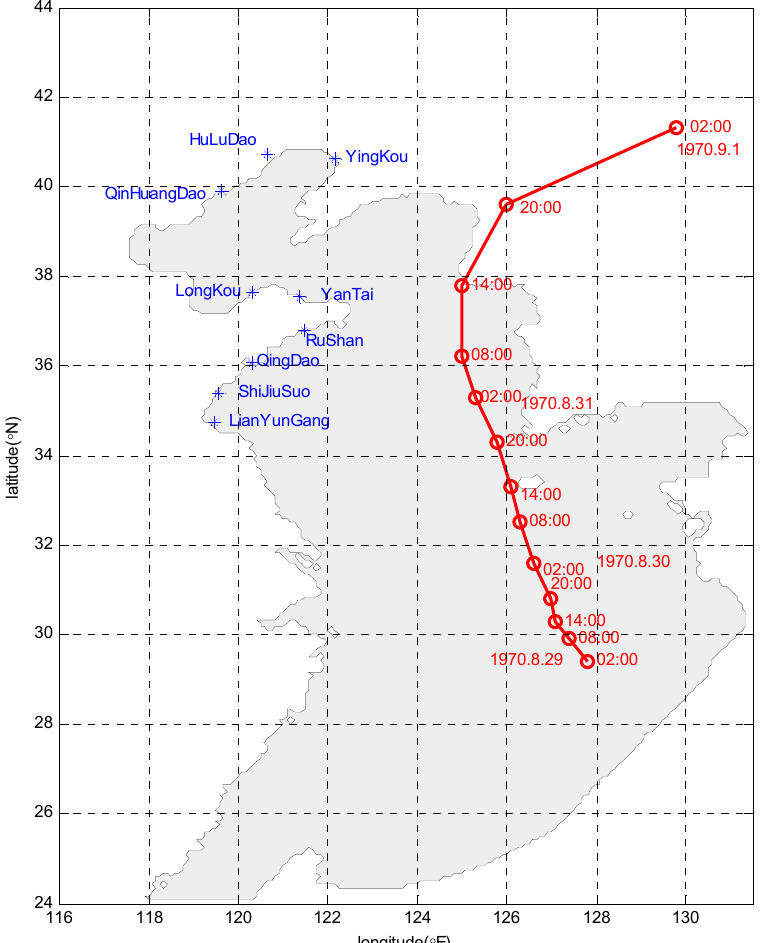
Figure 1. Positions of tidal stations and track of Typhoon 7008. Blue asterisks indicate the positions of tidal stations. The red solid line denotes the track of Typhoon 7008. Red circles denote the time.